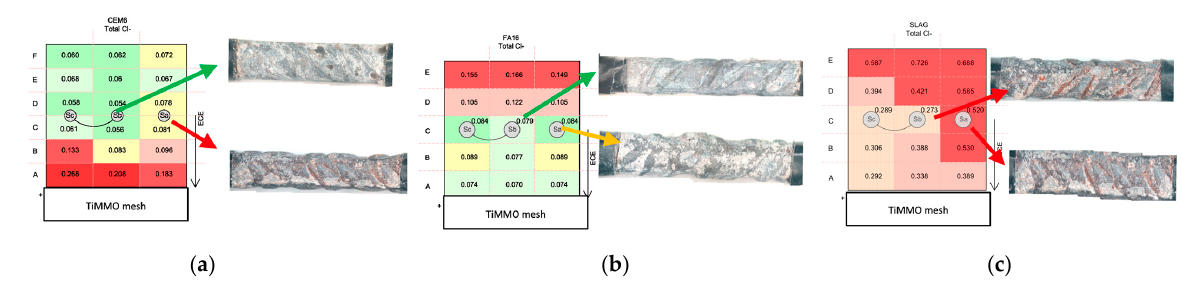
Figure 13. Visual inspection of the steels. ( a ) CEM I specimen; ( b ) FA specimen; ( c ) SLAG specimen.